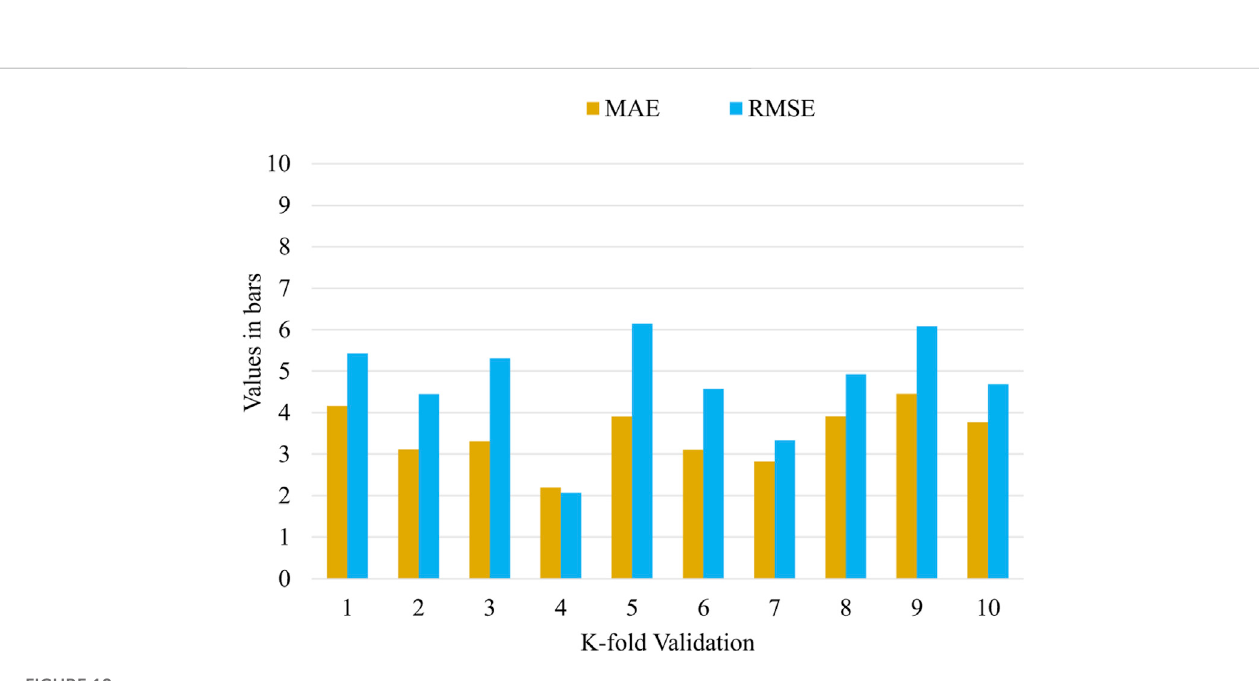
FIGURE 17 MLP model statistical analysis.